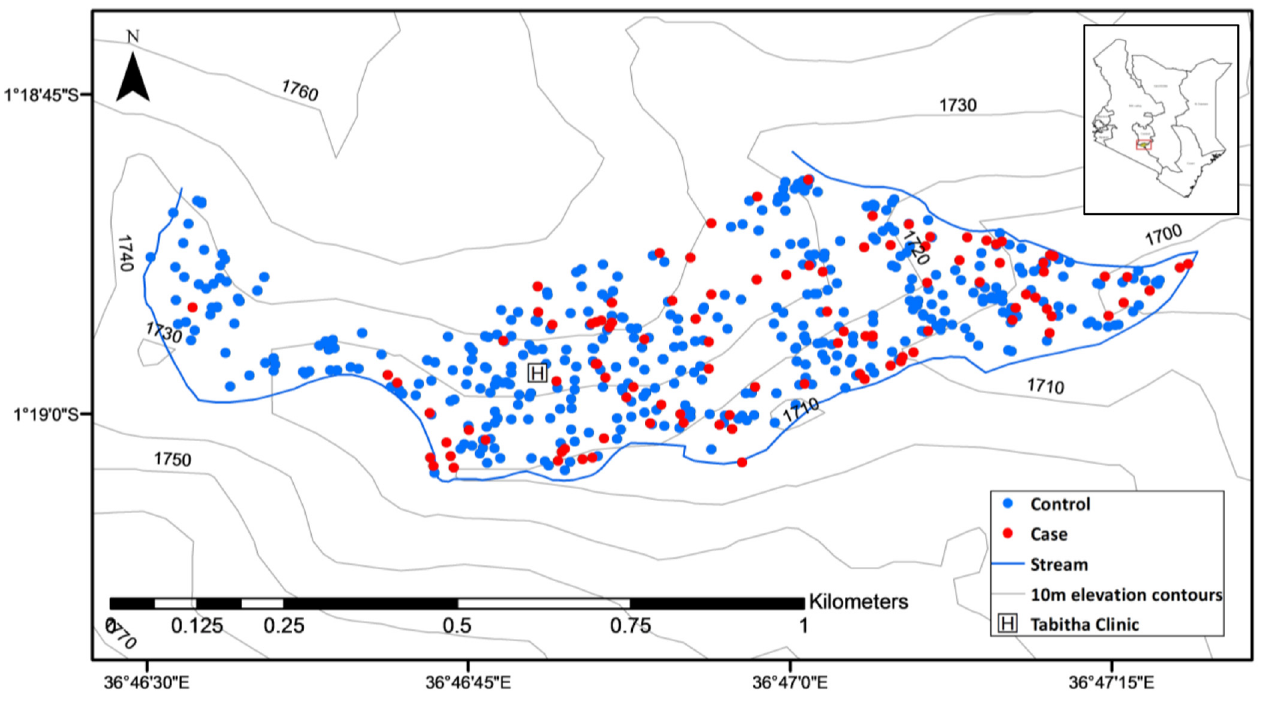
Fig 1. Spatial distribution of 110 cases and 440 controls between 2010 – 2011 in Kibera,